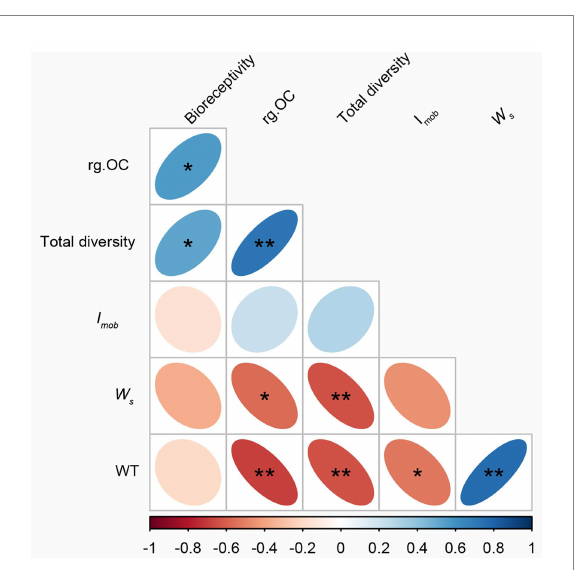
FIGURE 7 Correlation of weathering time with weathering degree, diversity index, and organic carbon. * p < 0.05, ** p <